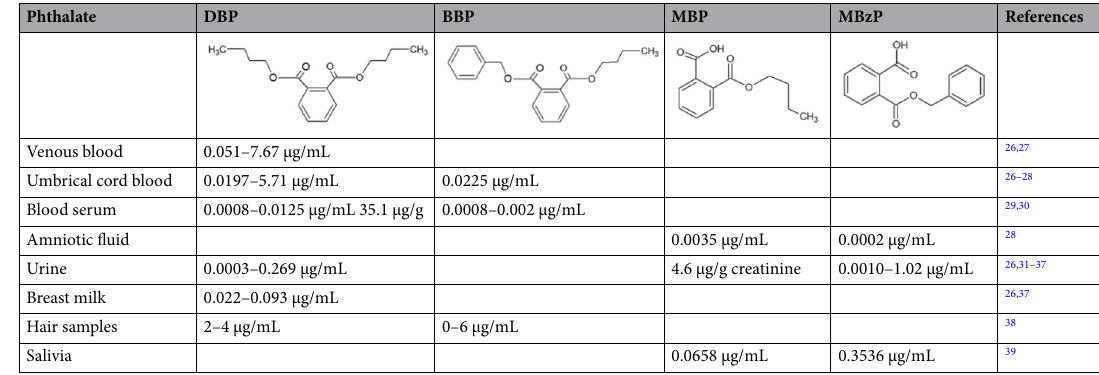
Table 1. Concentration range of phthalates and their metabolites determined in human